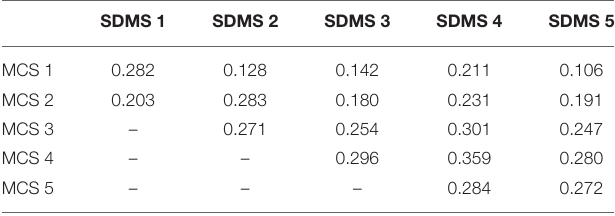
TABLE 2 | Intercorrelations between SDMS and MCS across all studies.